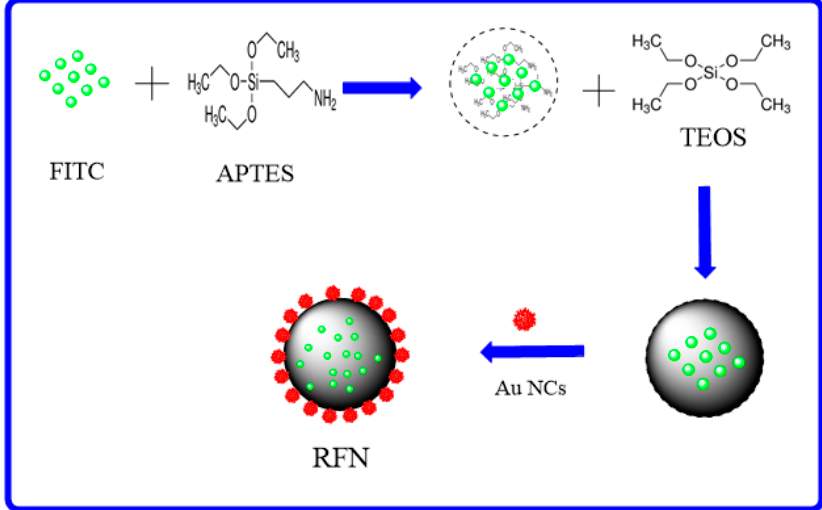
Scheme 1. Schematic illustration for preparation of the RFN.